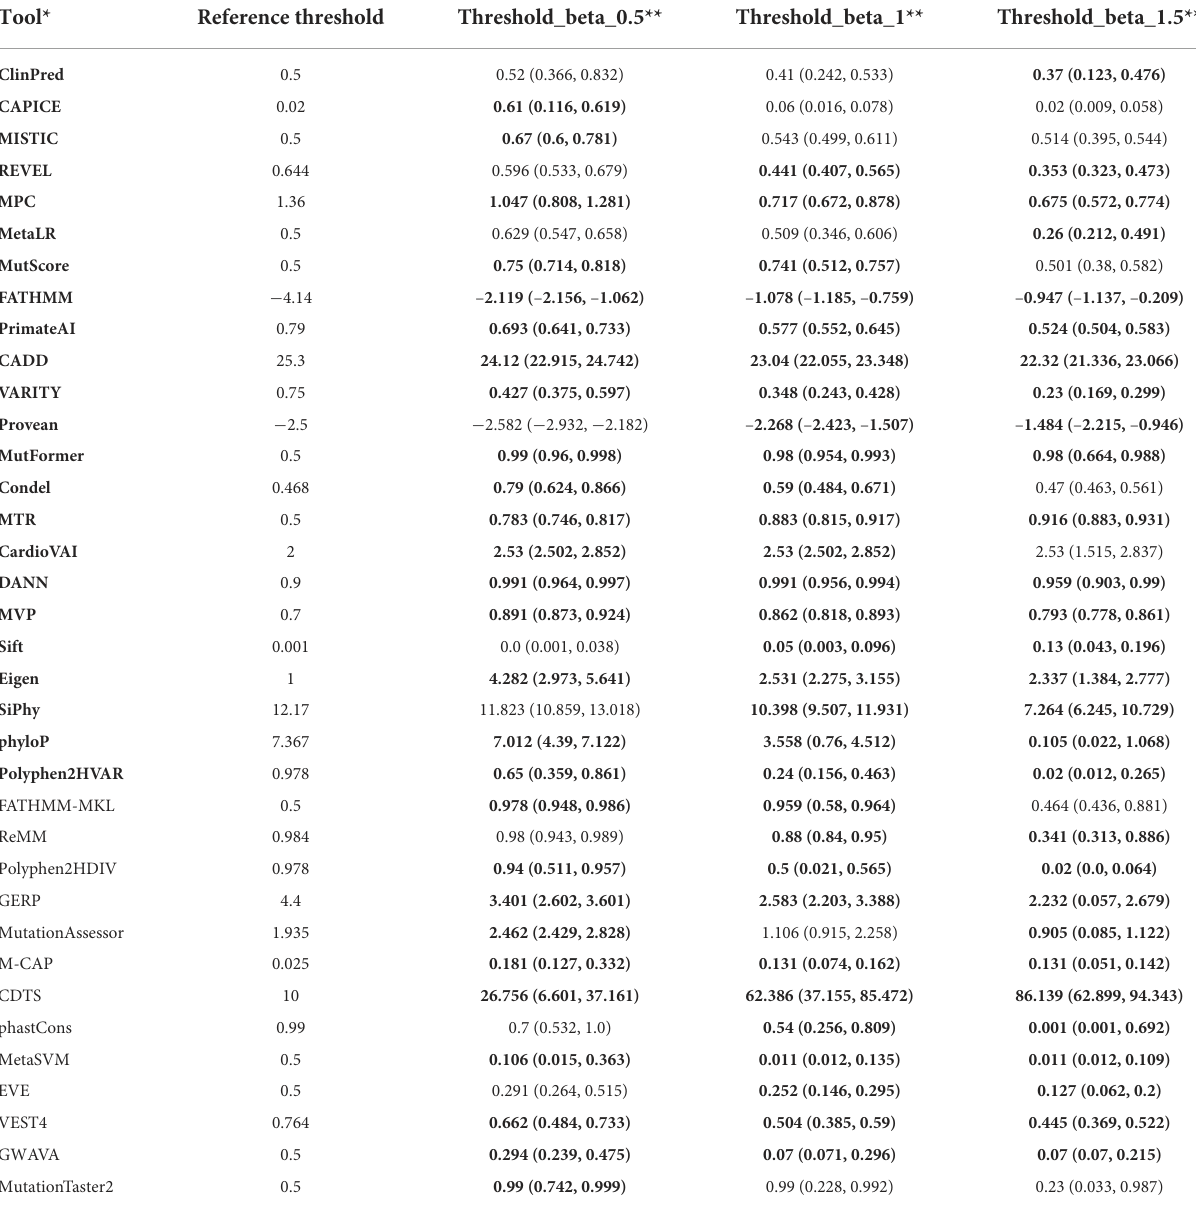
TABLE 2 Adjusted thresholds that maximize performance for HCM variants at different levels of importance given to precision and